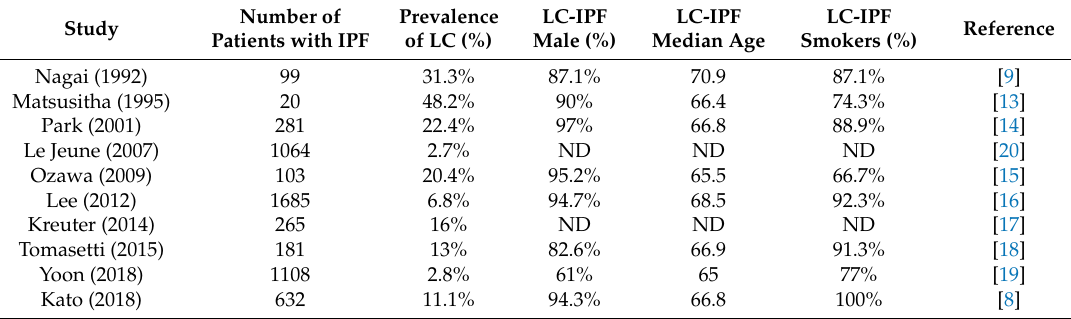
Table 1. Prevalence of lung cancer (LC) in idiopathic pulmonary fibrosis (IPF) patients.